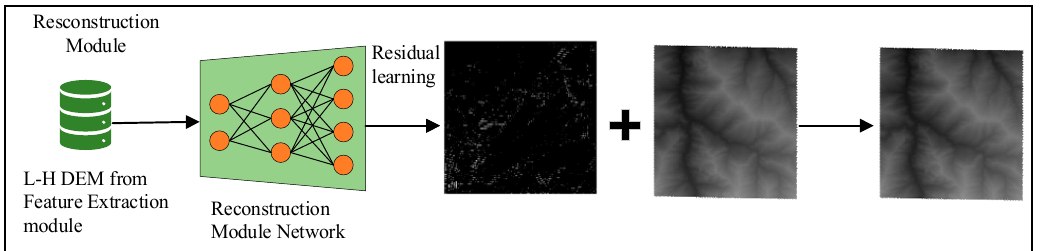
Figure 2. The processing flow of the feature reconstruction module.